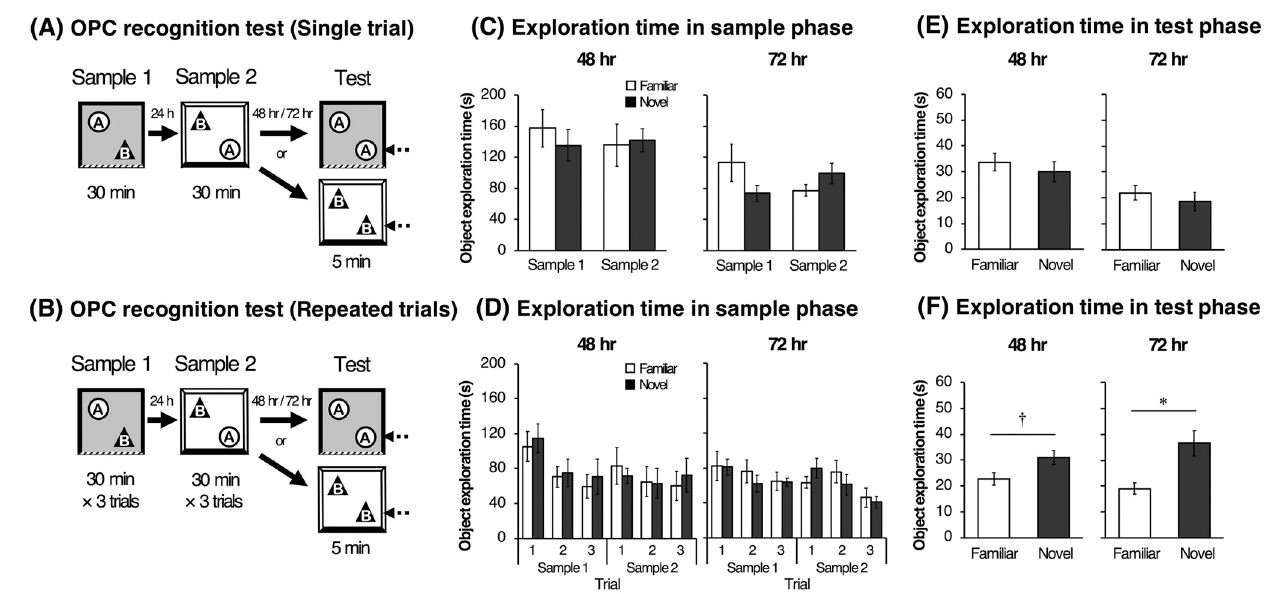
Fig 2. Schematic illustrations of OPC recognition test in Experiment 2–1 (A) and 2–2 (B). In each sample phase, rats were subjected to one (Experiment 2–1) or three trials (Experiment 2–2) of the 30-min familiarization. The sample 2 and test phases were separated by either of retention interval conditions (48 or 72 hr). Mean ( ± SEM) time spent in exploration for each object in sample phases (C, D), in test phase (E, F). A two-way (Phase × Object) and three-way (Phase × Trial × Object) ANOVA followed by a post-hoc Scheffe test was used for the analysis of the exploration time in sample phases. A paired Student’s t- test was used for comparison the exploration time between familiar and novel objects in test phase. � p < .05. † p < .10.